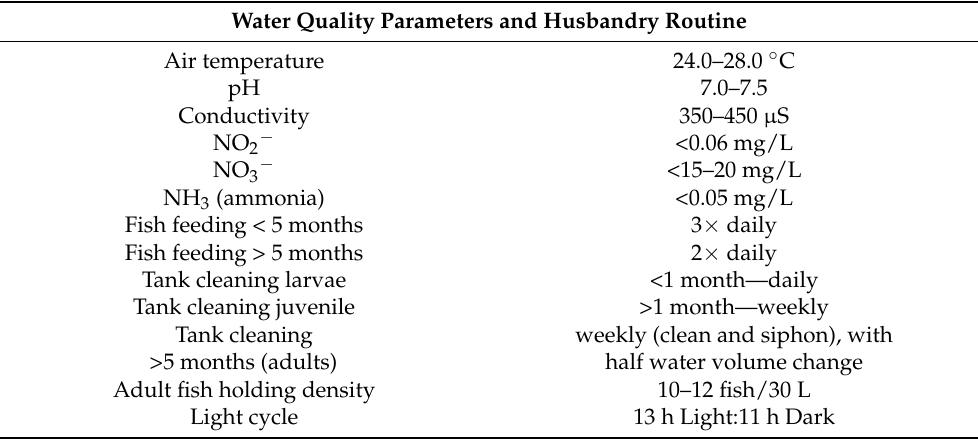
Table 1. Summary of the water quality parameters and husbandry routine in the